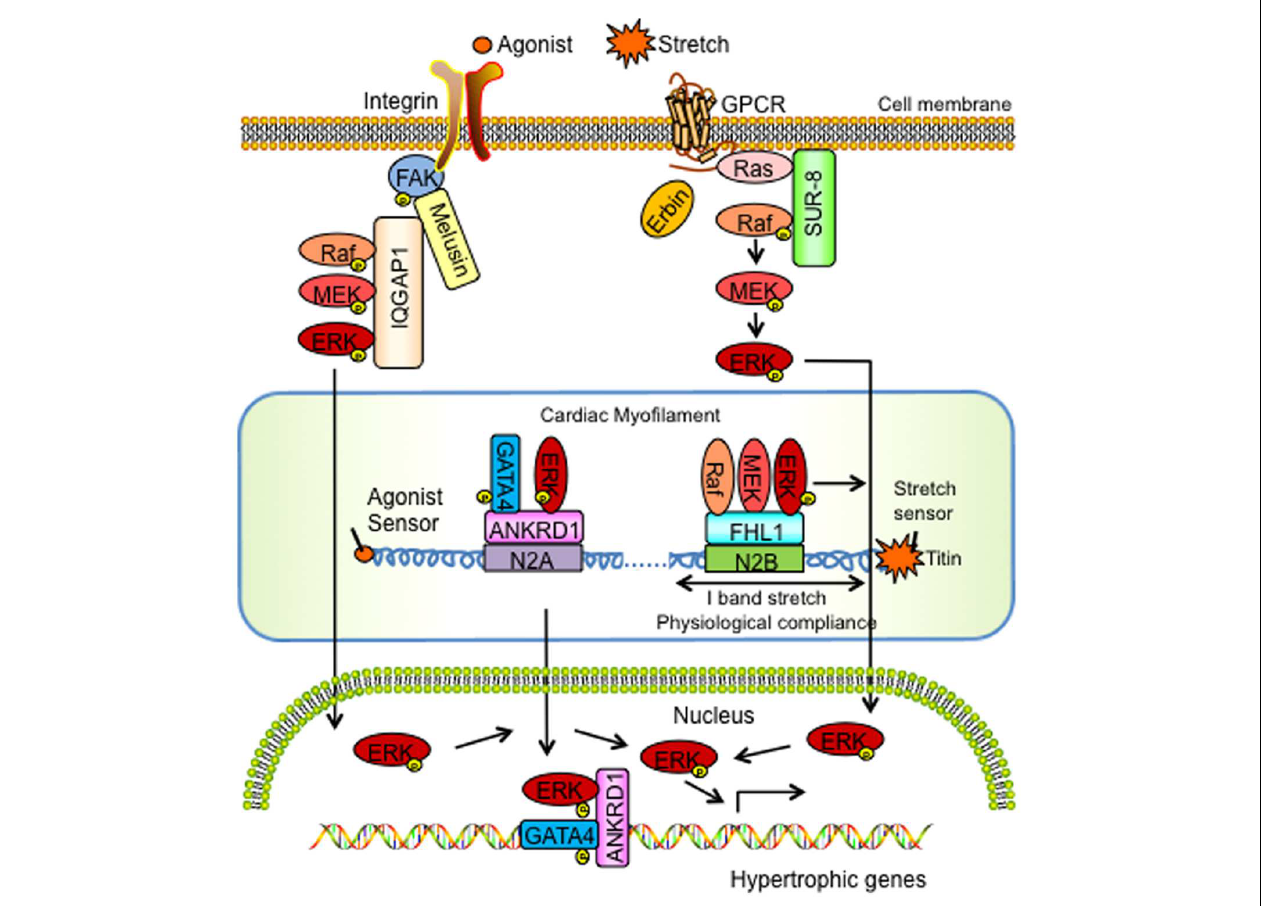
FIGURE 1 | Schemata of the signaling actions of MAPK scaffolding proteins in cardiac hypertrophy and disease. ANKRD1, Ankyrin Repeat Domain 1; ERK, extracellular signal-regulated kinase; FAK, focal adhesion kinase; FHL1, Four and a half LIM domain protein-1; GATA4, GATA binding protein-4; GPCR, G Protein Coupled Receptor; IQGAP1, IQ motif-containing guanine-5 (cid:48) -triphosphate hydrolase activating protein; MEK, mitogen-activated protein kinase kinase; SUR-8, Suppressor of